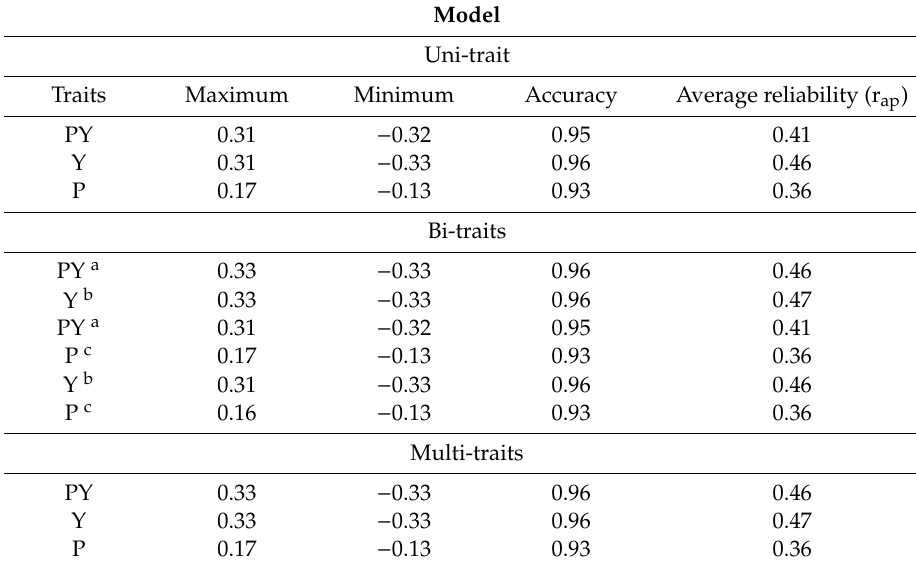
Table 4. Range of estimated breeding values (EBVs), accuracy and average reliability of EBVs obtained for PY, Y and P traits estimated by uni-bi-multi-traits models in Murciano-Granadina goats. Model